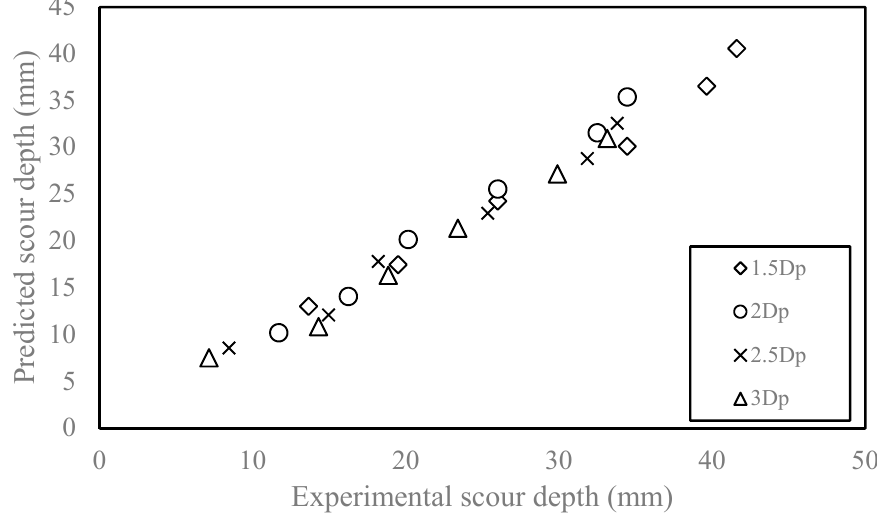
Figure 8. Comparison between the experimental scour depth and predicted scour depth.